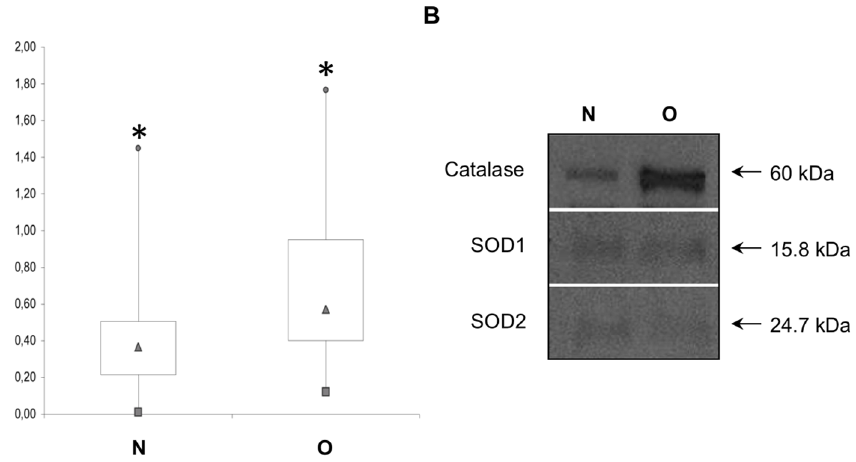
Figure 4. Biochemical variability in salivary samples of N and O subjects. Box plot representation of Total Antioxidant Capacity of normal- weight (N) and obese (O) salivary samples. Box outline represents lower and upper quartiles, squares and circles correspond to the smallest and largest observations, the triangle is the median value; *P # 0.01 (A). Western blotting analysis of catalase, SOD1 and SOD2 (B).